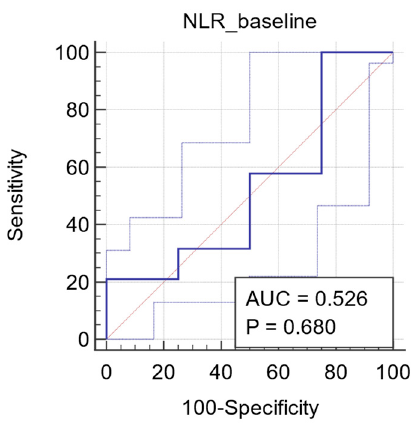
Figure 3. ROC curve for NLR after three cycles. Plot of the receiver operating characteristic curve of the NLR assessed after three cycles of NACT as a predictor of objective tumor response.